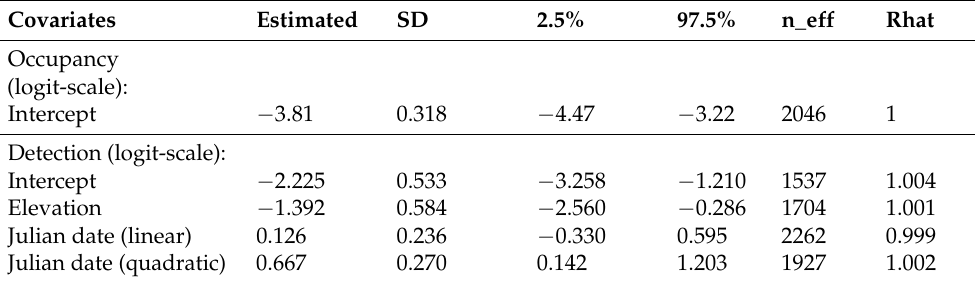
Table A6. Output summary from the best occupancy model ( ψ (intercept); ρ (intercept + elevation + Julian day + Julian day 2 )) of house sparrow ( Passer domesticus ) in Puerto Rico. Runtime: 11.022 min.